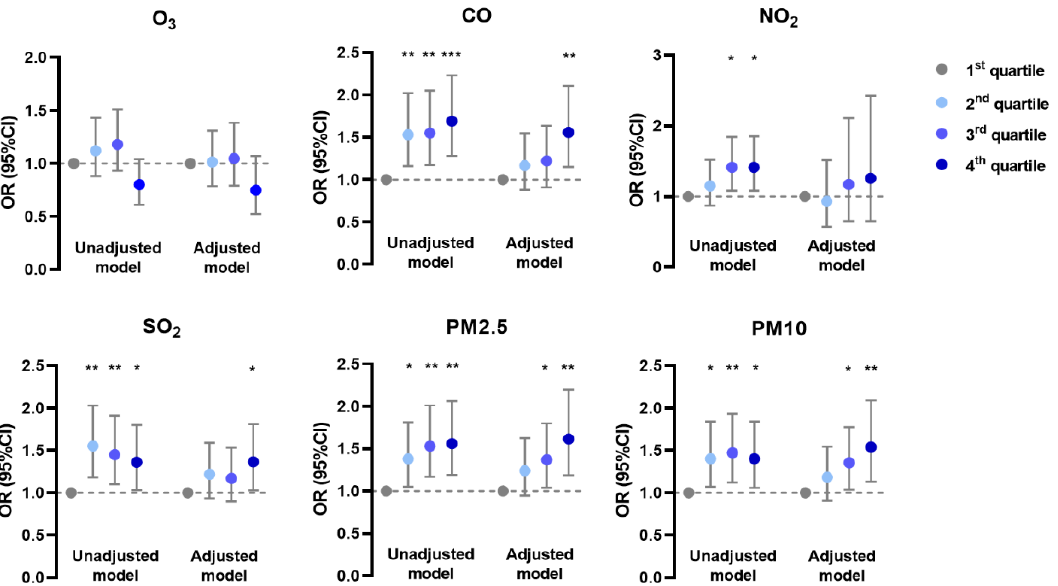
Figure 2. Association between chronic hand eczema and adjusted daily dose of ambient air pollu- tants. The unadjusted model describes the crude OR; the adjusted model was adjusted for demo- graphic variables, behavioral habits, and environmental factors. * 0.01 < p < 0.05; ** 0.001 < p < 0.01; *** p < 0.001.